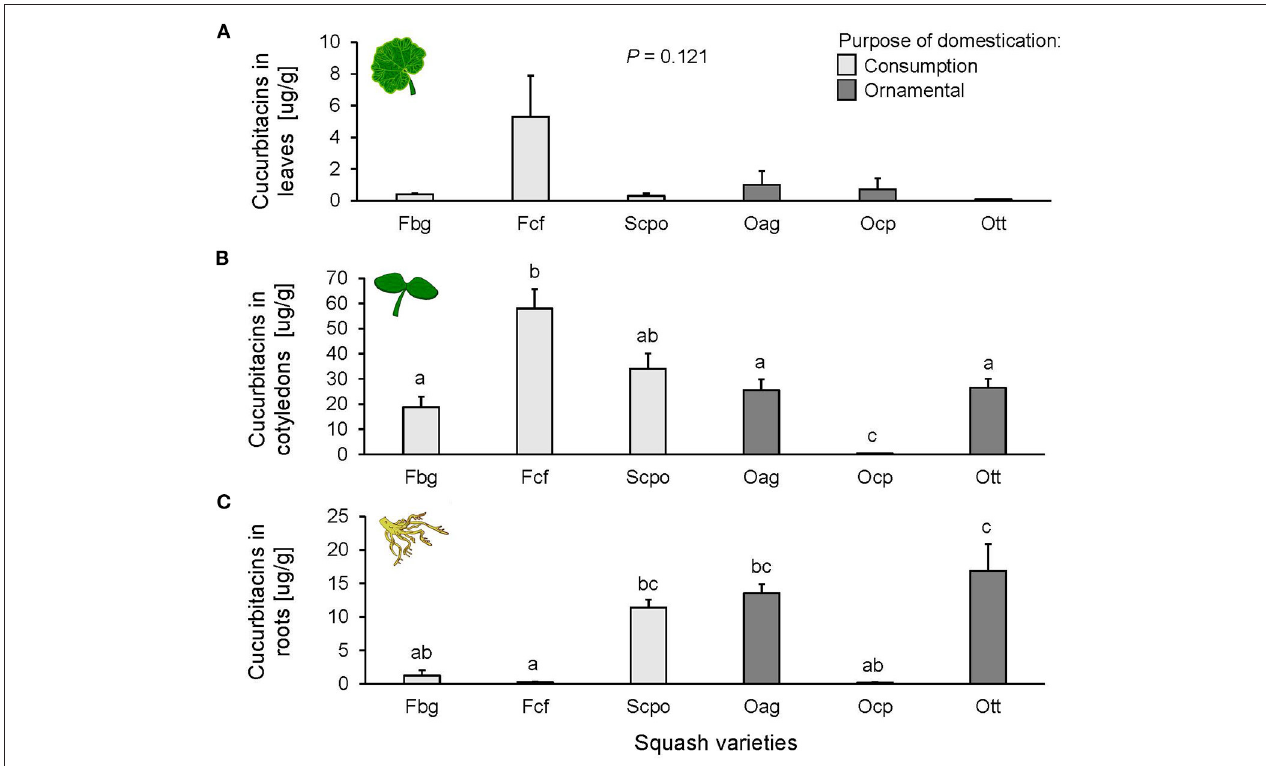
FIGURE 1 | Cucurbitacin concentration in (A) leaves ( n = 3), (B) cotyledons ( n = 3), and (C) roots ( n = 3) of the studied Cucurbita spp. varieties. The bars represent means ( ± SE). Light-colored bars are varieties domesticated for consumption and dark-colored bars are varieties domesticated for an ornamental purpose. P -values are given for treatment comparisons with log transformed data [linear model], followed by pairwise comparisons of Least Squares Means (LS